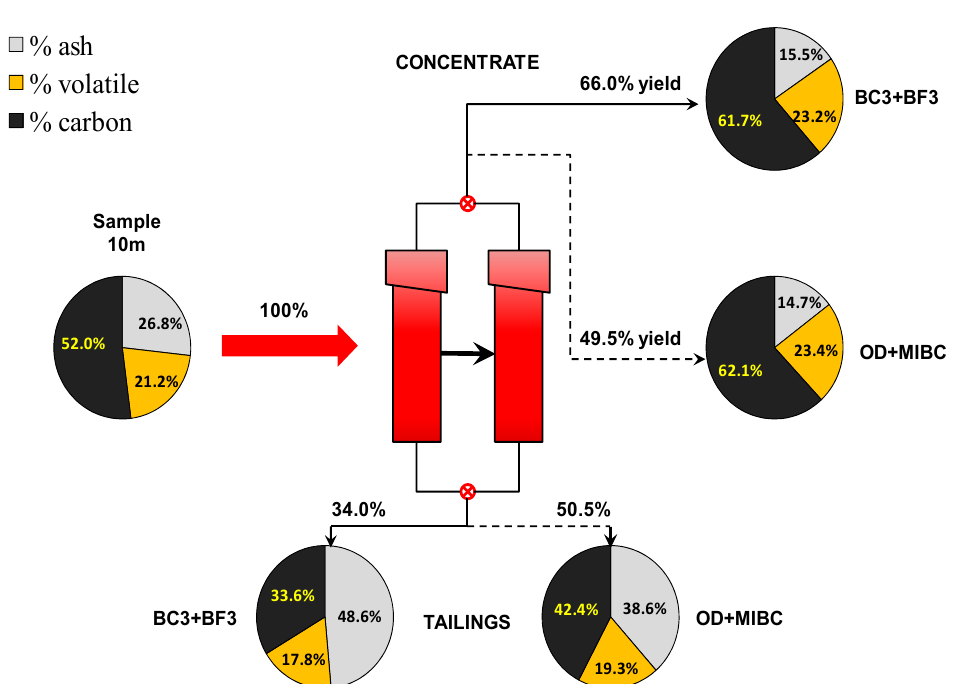
Figure 12. Mass balances of the best bene fi ciation scenarios for each reagent system (10 m distance).